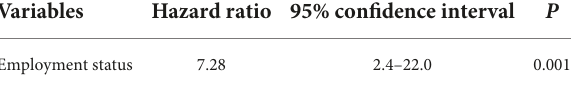
TABLE 4 The Cox proportional hazards model with likelihood ratio method (forward selection) for job group in work maintenance.